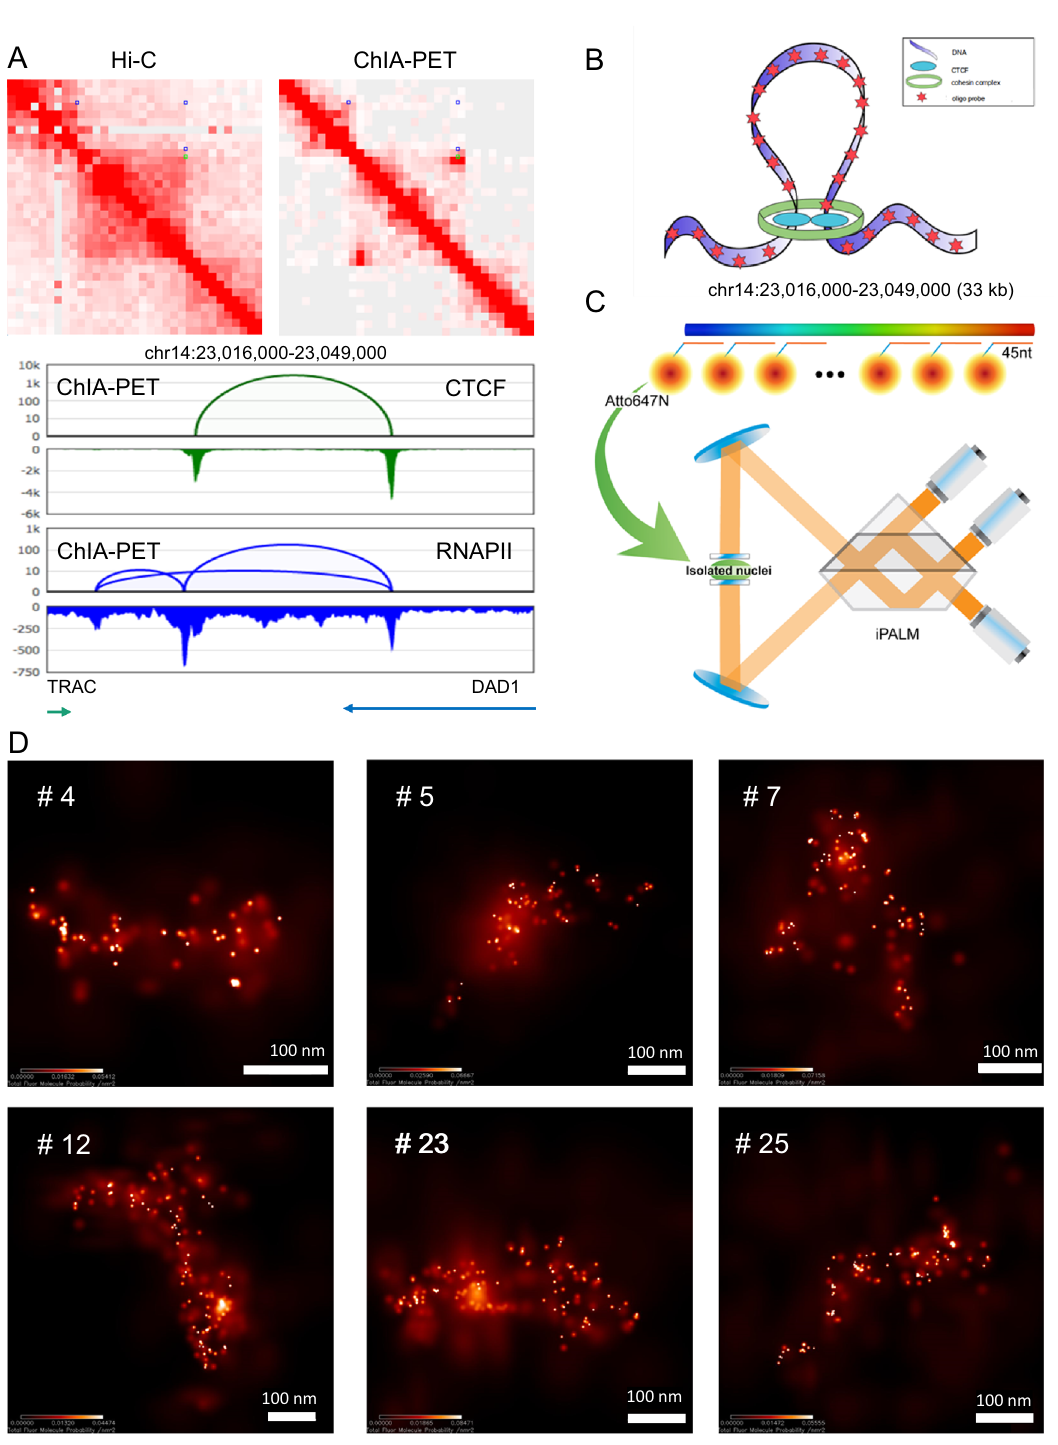
Figure 1. iPALM imaging of a target chromatin loop region. ( A ) GM12878 Hi-C 54 (top left) and CTCF and RNAPII merged ChIA-PET 18 (top right) contact map for the target region chromosome 14: 23.016–23.049 Mb (hg19, 1 Kb resolution with balanced normalization), as well as ChIA-PET genome browser view for the same region (bottom). ChIA-PET loops (green for CTCF and blue for RNAPII) are also presented on top of the upper diagonal area of the contact maps. In the browser view, CTCF loops and peaks (green), RNAPII loops and peaks (blue), and genes localized in the target region are presented. ( B ) Schematic of the target loop region inferred by ChIA-PET data with attached oligopaint probe. ( C ) Schematic of the iPALM method. The probe set contains 336 DNA oligos tagged with Atto647N designed to stain along the target chromatin region ( D ) Representative images of the target region from 6 different cells obtained by